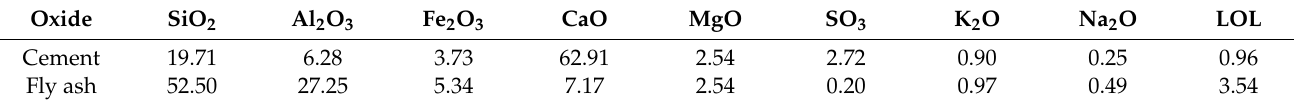
Table 2. Chemical composition of cement and fly ash.